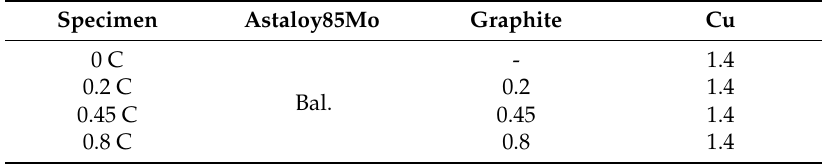
Table 1. Chemical composition (mass %) of powder metallurgy (PM)